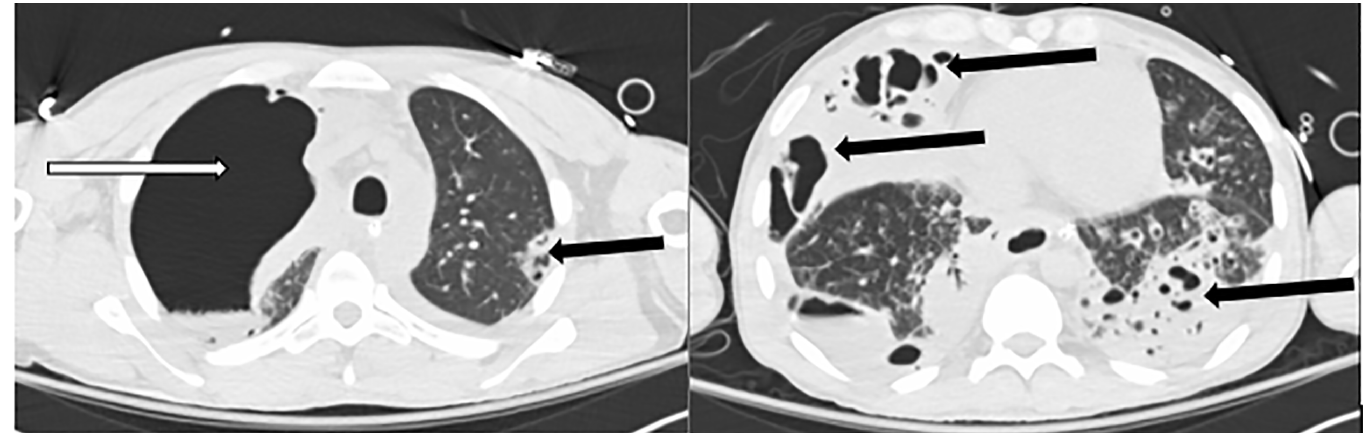
Images 3. Thorax computed tomography transverse plane demonstrating giant right upper lobe bulla (white arrow) as well as multifocal pneumonia and bronchiectasis in both images at differing levels (multiple black